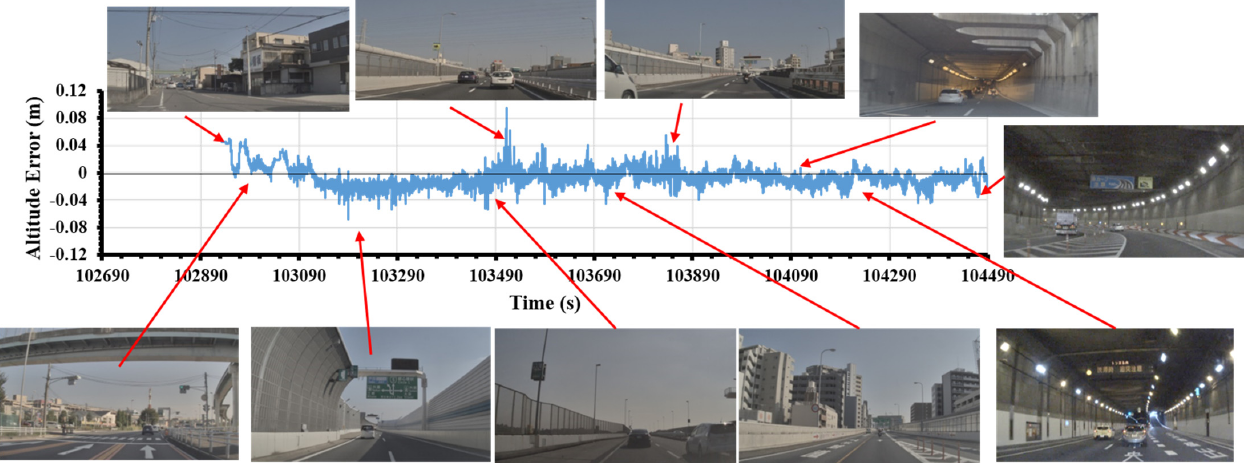
Figure 10. The trajectory between Yono and Ohashi highway junctions with front camera images of ground, bridge, tunnel and entrance of Ohashi.